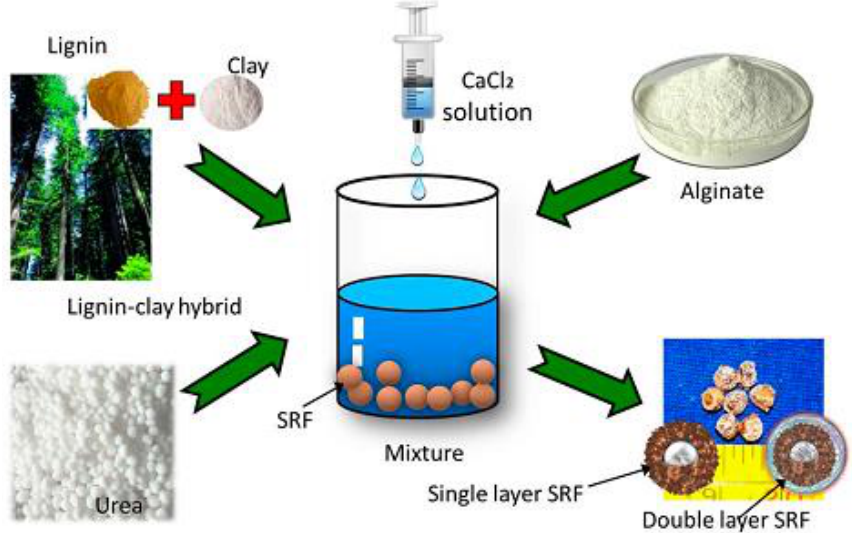
Figure 3. The synthesis procedure of double-layer SRFs using bio-based coating materials (reproduced from ref. [59]; copyright 2020 American Chemical Society).